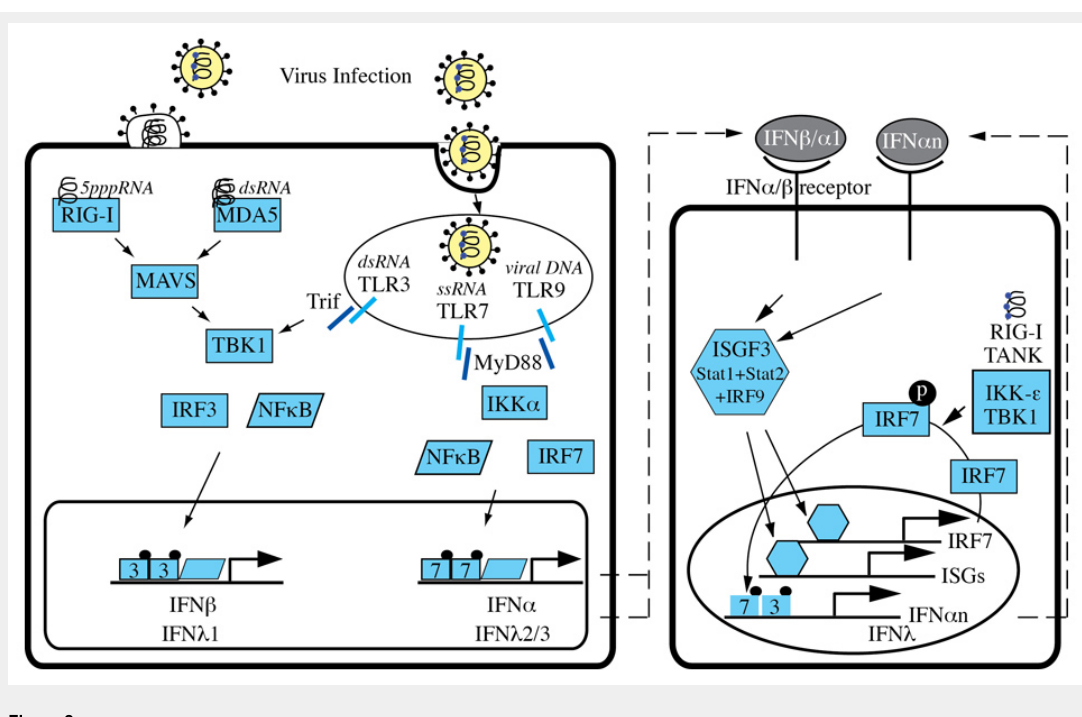
Figure 2 Induction of IFNs. Viral infections are sensed by two important pathways: the toll-like receptor (TLR) dependent pathway and the cytosolic pathway triggered by binding of viral RNA to the RNA helicases retinoic acid inducible gene-I (RIG-I) and melanoma differentiation antigen 5 (MDA5). RIG-I and MDA5 signal through MAVS and TBK1 to activate the transcription factors IRF3 and NFκB. TLR3 signalling depends on the adaptor TRIF to activate TBK, IRF and NFκB, whereas TLR7 and TLR9 use the MyD88-IKKα pathway to activate IFN gene